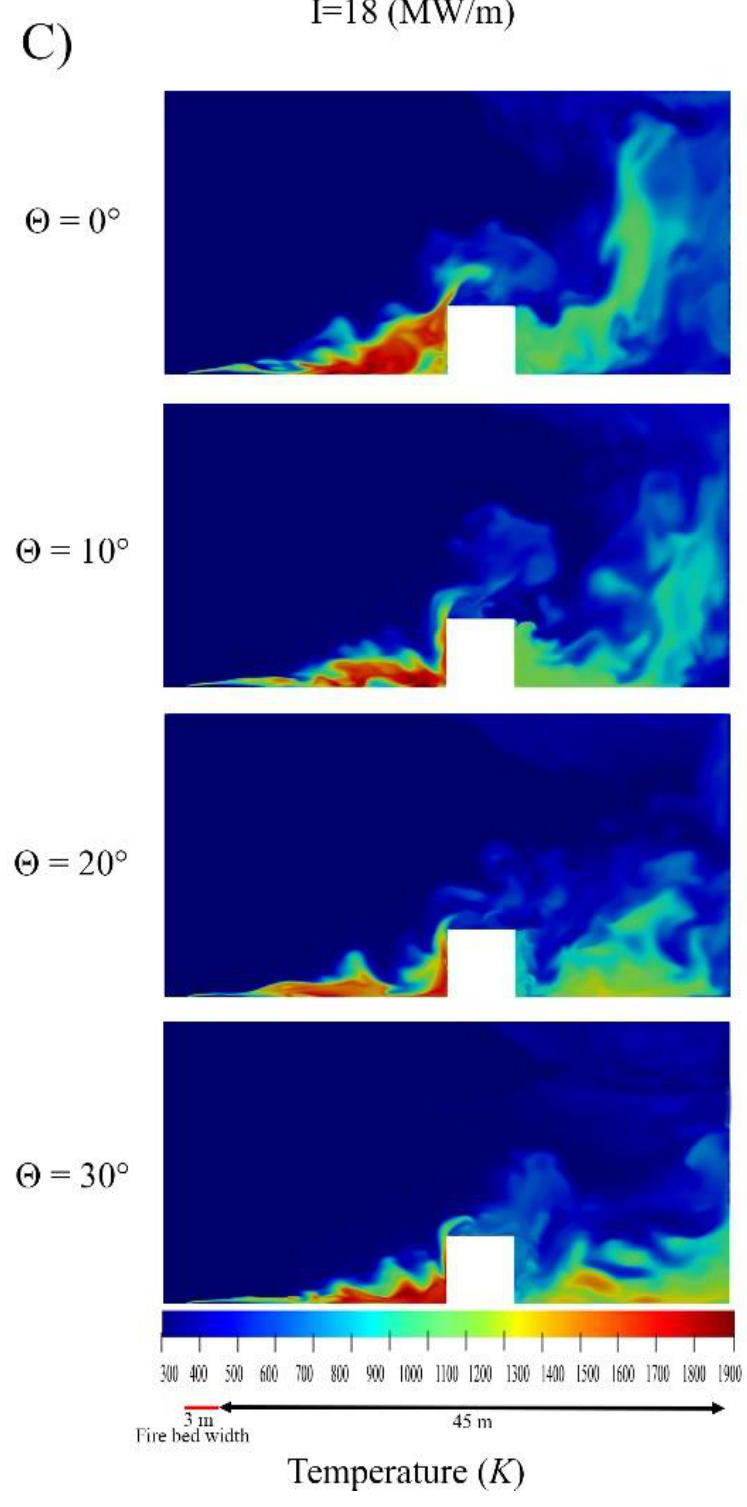
Figure 4. Time-averaged plot of temperature distribution for the reference velocity U ref = 6 m/s in various fire intensities and sloped terrain ( A ) Fire intensity of 10 (I = 10 MW/m), ( B ) Fire intensity of 14 (I = 14 MW/m) and ( C ) Fire intensity of 18 (I = 18 MW/m). Looking at the contours of temperature distribution in the vicinity of the building and on the ground close to the building, it is evident that by increasing fire intensity and